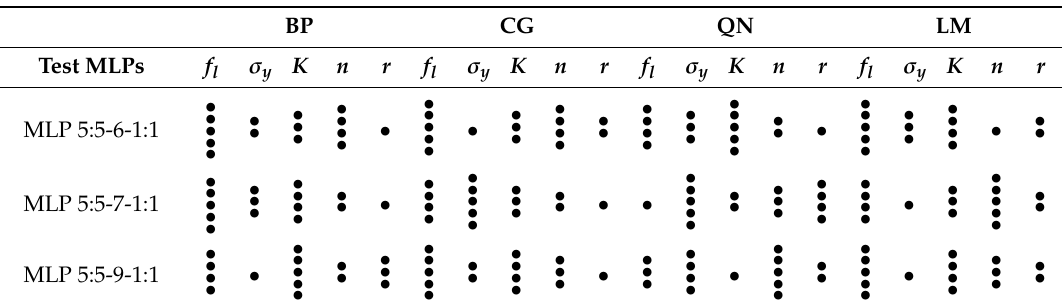
Table 4. Sensitivity analysis of the test MLPs.